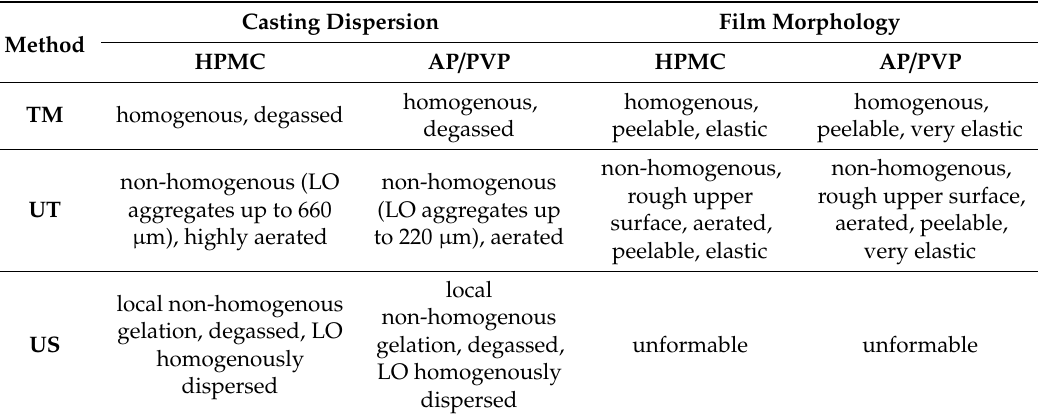
Table 1. Comparison of the homogenization methods (TM—planetary mixer Thinky; UT—Ultra